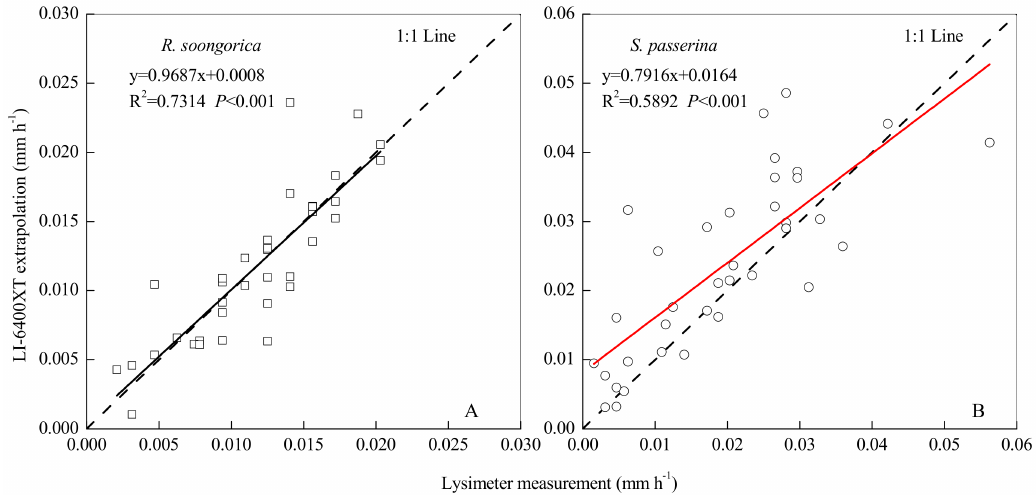
Figure 6. Relationships between Lysimeter measurements ( A ) and LI-6400XT extrapolation ( B